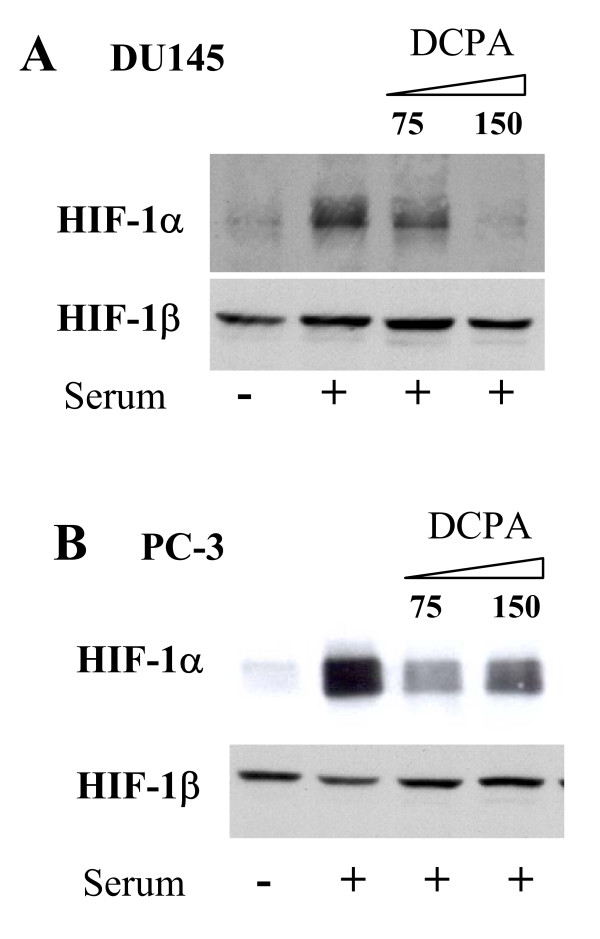
Expression of HIF-1α was specifically induced by the addition of serum, and inhibited by the presence of DCPA. DU145 (A) and PC-3 (B) cells were cultured in serum-free MEM basal medium with Earle's salt in 0, 75, or 150 μM DCPA for 24 h, followed by the incubation with or without 10% fetal bovine serum for 6 h. Total cellular protein extracts were prepared from these cells, and aliquots of the extracts (30 μg) were used for the immunoblotting analysis using antibodies against HIF-1α and HIF-1β.